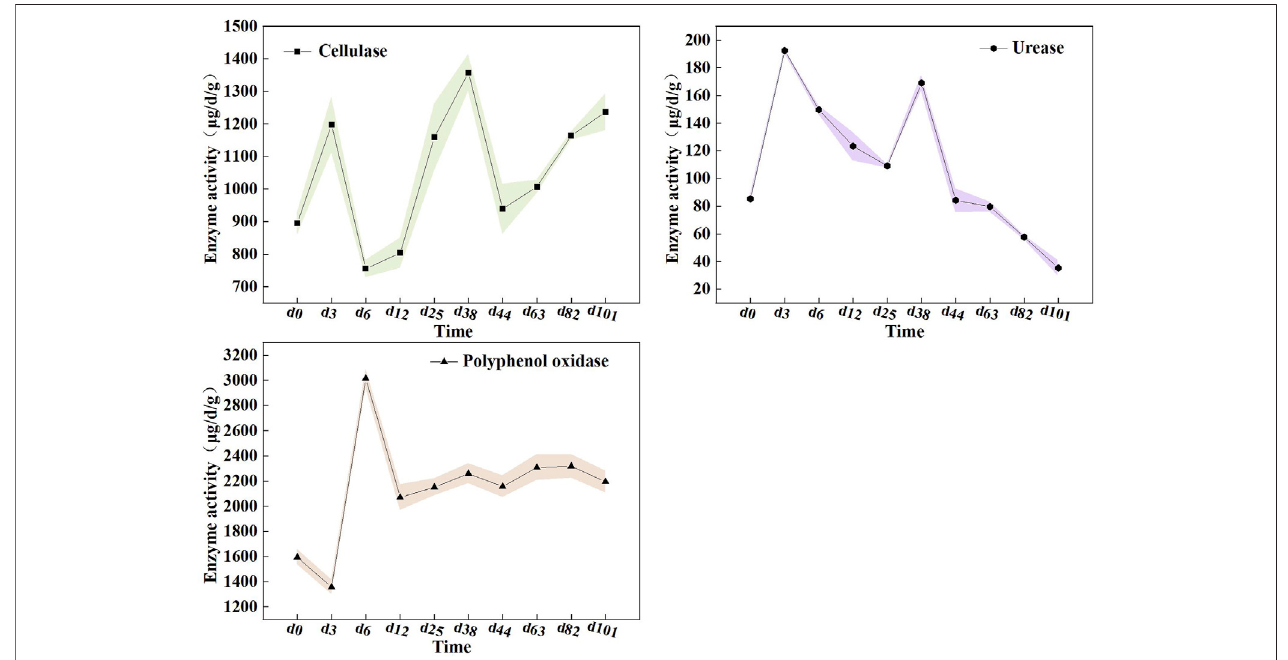
FIGURE 3 | The activities of emzymes during composting. (a) cellulase, (b) urease and (c) polyphenol oxidase.